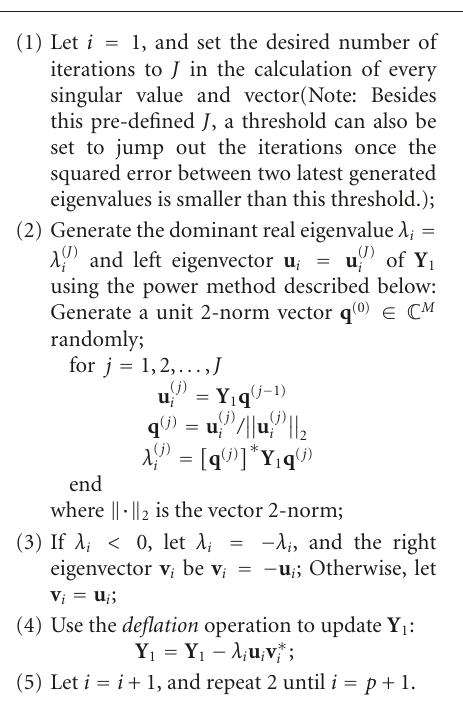
Algorithm 1: Algorithm to generate p principal singular